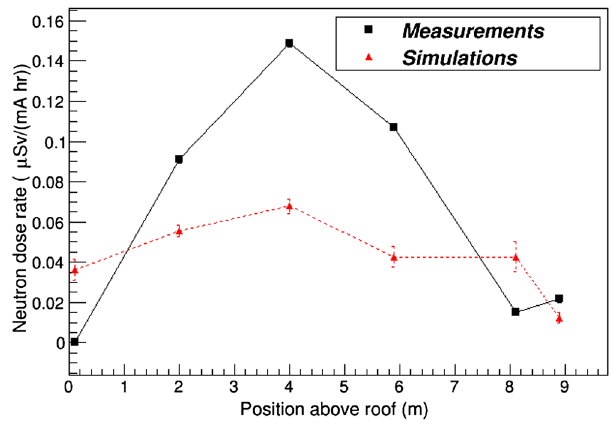
FIG. 5. Comparison between measured data (black squares) and simulated data (red triangles). The lines are a guide for the